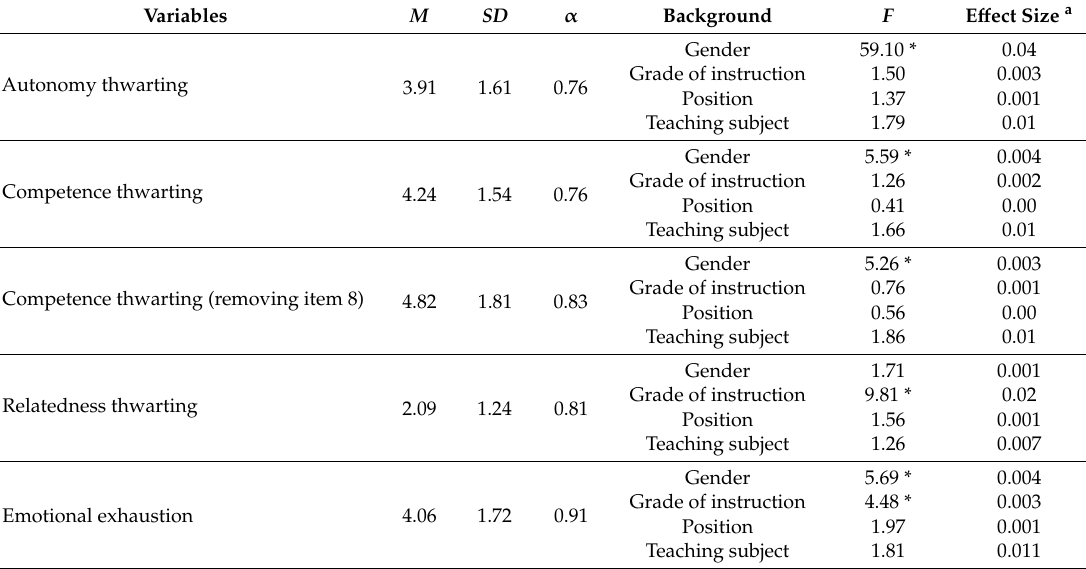
Table 1. Descriptive statistics, internal reliability, and between-subjects